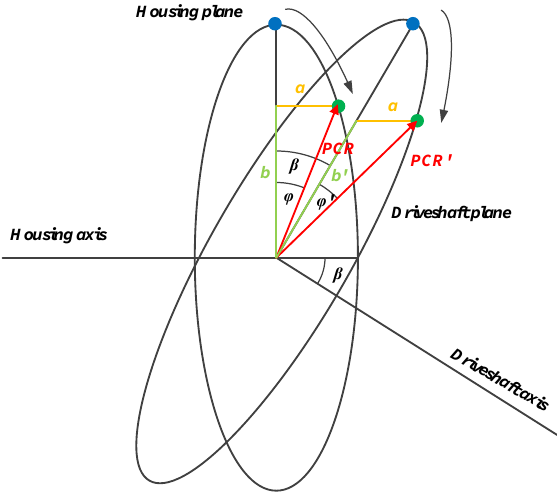
Figure 2. Phase angle and PCR in articulated condition.